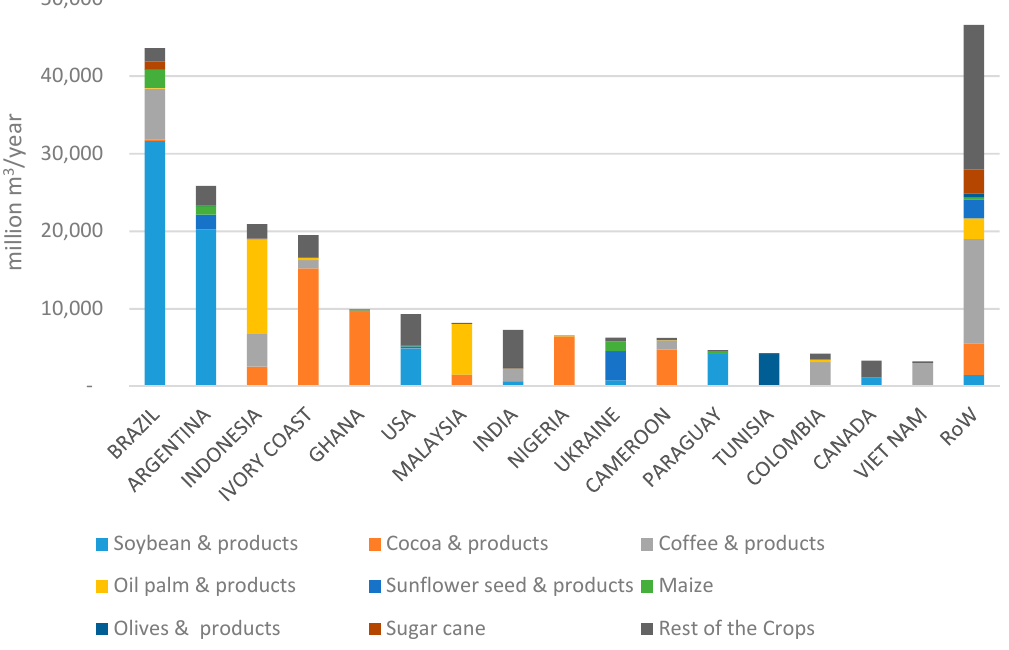
Figure 4. Green virtual water imports to the EU per country, per crop product and product groups (million m 3 /year). RoW; Rest of the World.